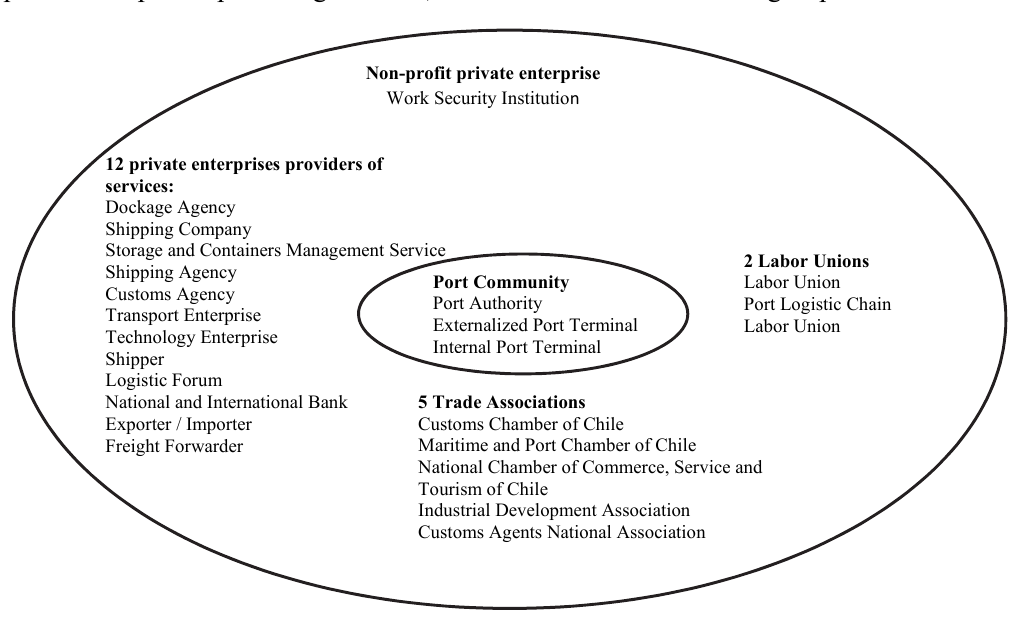
Fig. 1. Private actors integrating the chilean port